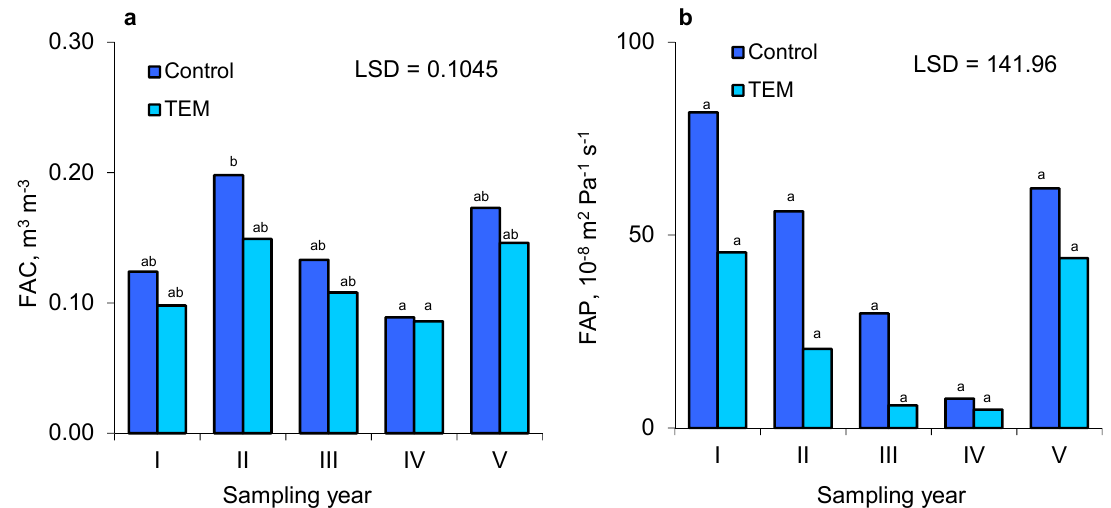
Figure 5. The annual mean values of field air capacity (FAC) ( a ) and air permeability (FAP) ( b ) of soil (at − 15.5 kPa) during the five-year study. Notes: Control: soil without EM-A ( n = 150), TEM: soil with EM-A application ( n = 150), I–V: study year. Each letter (a, ab, and b) means a significant di ff erence (Control or TEM × study year) according to Tukey’s lowest significant di ff erence